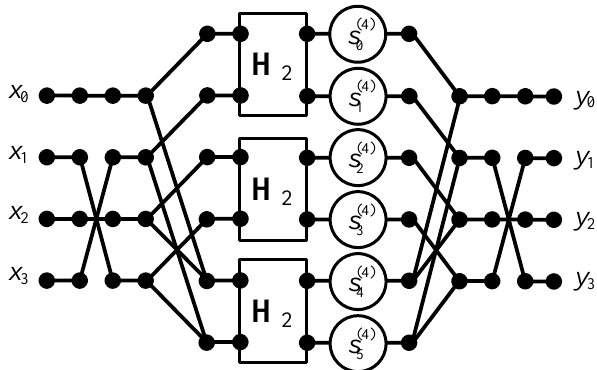
Figure 3. Signal flow graph of the algorithm for computing the 4-point